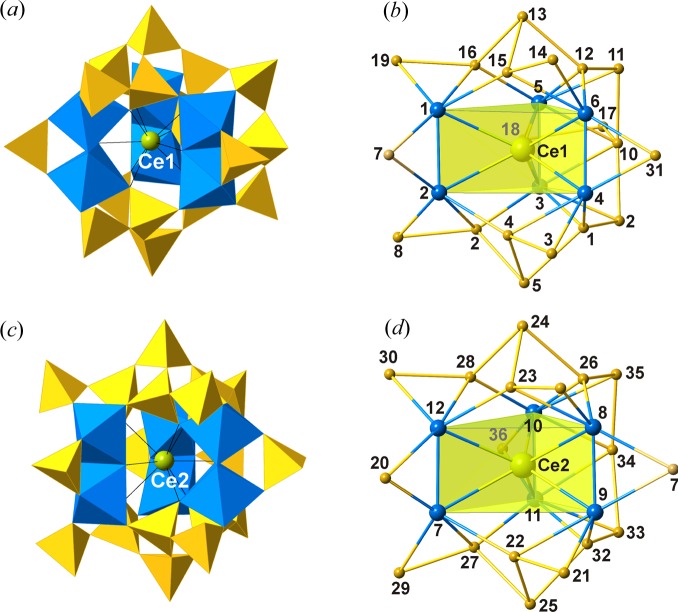
TPTS clusters in the crystal structure of ilmajokite shown in (a) and (c) polyhedral and (b) and (d) nodal representations. The numbering scheme corresponds to the numbering of Si and Ti atoms from the experiment. The Ce-centered Ti6 trigonal prism is highlighted in yellow. The legend follows that of Fig. 1 ▸.